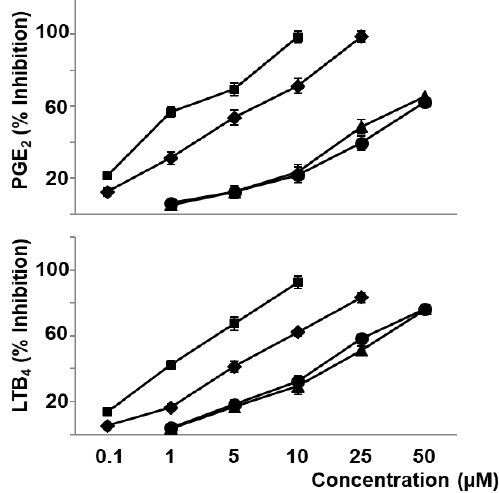
Figure 2. E ff ect of bioactive compounds of sofrito on prostaglandin E 2 and leukotriene B 4 production stimulated by oxLDL. Macrophages were incubated with naringenin ( (cid:7) ), hydroxytyrosol ( (cid:4) ), lycopene ( (cid:78) ), or β -carotene ( (cid:8) ) for 30 min, and then stimulated with oxLDL (50 µ g protein / mL) for 30 min. Finally, PGE 2 or LTB 4 were measured. Data are the means ± SEM of three experiments performed in triplicate. Interestingly, we did not observe any e ff ect of these compounds on non-stimulated cells (data not − shown), but we observed an additive e ff ect of these compounds on O 2 , PGE 2 , and LTB 4 formation induced by oxLDL (Figure